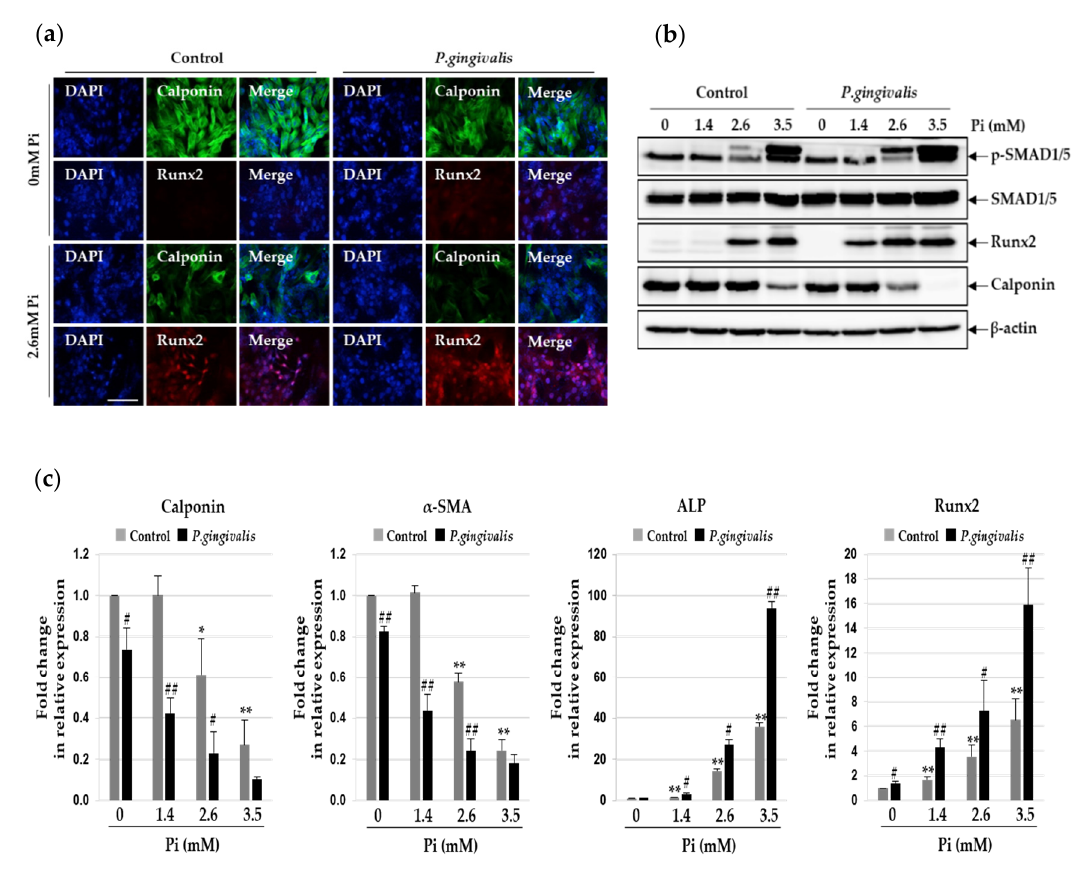
Figure 2. E ff ect of P. gingivalis on Pi-induced osteogenic transition in VSMCs. P. gingivalis -infected A7r5 cells were cultured for five days in calcification medium containing 2.6 mM Pi. ( a ) Higher magnification images showed immunoreactivity of Runx2 (red) and calponin (green) in P. gingivalis -infected cells under calcification conditions. (original magnification, × 400). Scale bar: 50 µ m. ( b ) Protein levels of Runx2, calponin, p-SMAD1 / 5, and SMAD1 / 5 were examined by Western blotting using their corresponding antibodies. β -actin served as the loading control. ( c ) Total RNA was isolated and analyzed by real-time PCR using primers specific for rat Runx2, ALP, calponin, and α -SMA. The expression levels of the control (untreated) were set to 1, and the values were normalized to β -actin mRNA levels. * p < 0.05; ** p < 0.01 vs. 0 mM Pi, # p < 0.05; ## p < 0.01 vs. control, one-way ANOVA followed by a Student’s t-test. Data shown are the mean ± SD, obtained for at least three independent experiments.